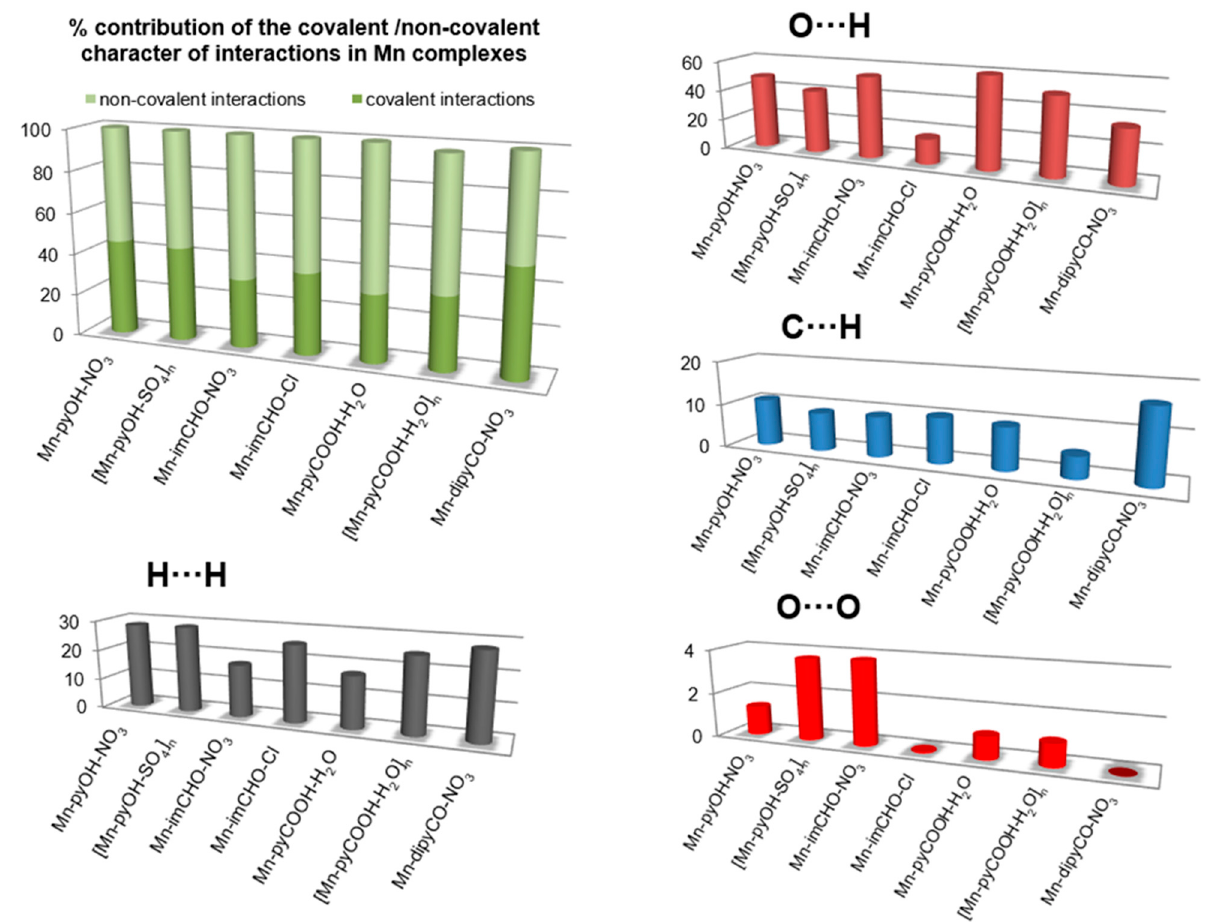
Figure 5. The plots for the most significant intermolecular interaction within the series of the Mn(II) complexes showing percentages of contacts contributing to the total HS area.